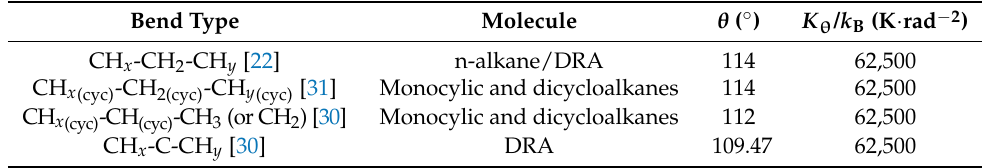
Table 4. Bond angle parameters for the TraPPE-UA force